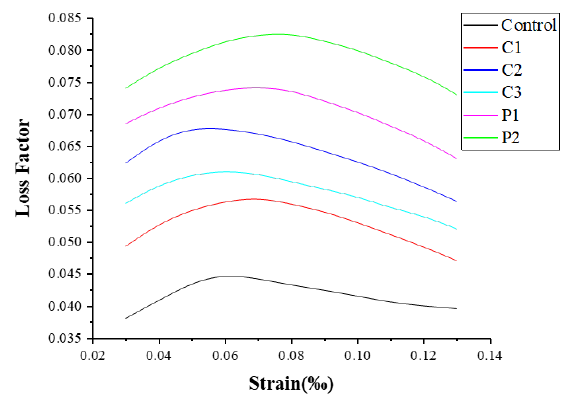
Figure 15: Tan δ of MDF cements as a function of the dynamic strain at